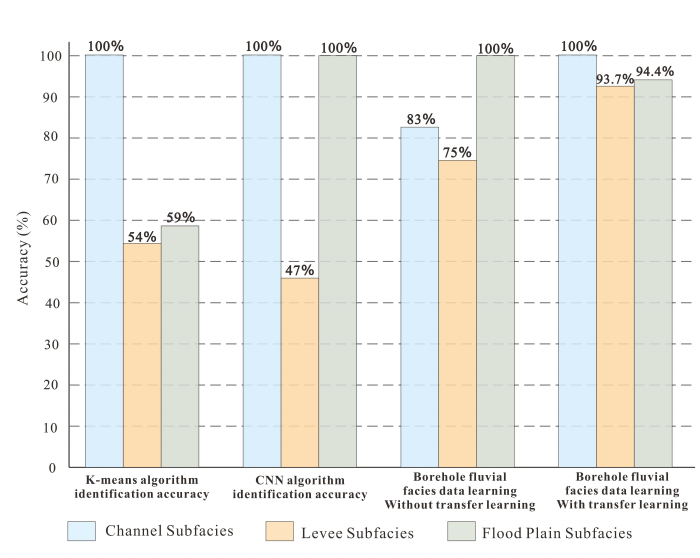
Figure 10. Comparison of algorithm identification accuracy.